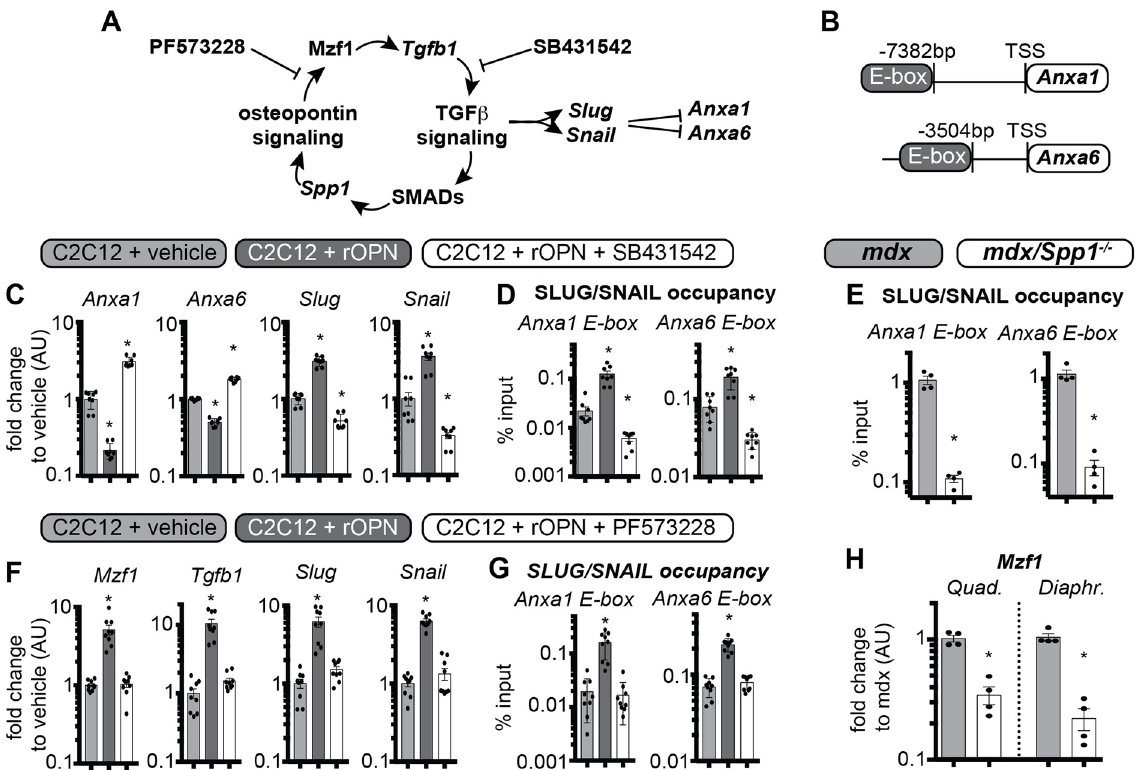
Fig 5. Excessosteopontin and TGF β activation inhibits Anxa1 and Anxa6 gene expression. A) Model depictingthe feed- forward loop in which osteopontin promotes TGF β , which in turn promotes Spp1 /osteopontinexpression. Slug/Snail expression, downstream of TGF β activation, results in Anxa1/Anxa6 gene repression. B) Diagramof putative E-box elementsupstream of transcriptional start site (TSS) of Anxa1 and Anxa6 genes in the murinegenome. C) qPCR analysisof C2C12cells after treatment with recombinant osteopontin (rOPN) or rOPN plus the TGF β inhibitor SB431452. rOPN increased Slug/Snail expression, and this was reversedin the presenceof SB431452. D) Correspondingly,ChIP-qPCR showed that the E-box occupancy of the Anxa1 and Anxa6 promoters by the SLUG/SNAIL protein complex was increasedby rOPN, and this was reversedin the presenceof SB431452. E) Anxa1 and Anxa6 promoter occupancy by SLUG/SNAIL was decreased in the myofiber fraction of mdx/Spp1 -/- muscle compared to control mdx muscle ( gastrocnemius ). F) PF573228, a chemicalinhibitorof OPN-driven signalingleadingto Mzf1-Tgfb1 axis activation,ablatedrOPN-induced upregulation of Slug , Snail , Mzf1 , and Tgfb1 . G) Accordingly, PF573228bluntedrOPN-dependent increasein SLUG/SNAIL occupancyon Anxa1/6 E-boxes in C2C12 myoblasts. H) Mzf1 , transcriptionalregulatorlinkingthe OPN and TGF β signalingcascades, was downregulated in both hindlimb( quadriceps ) and respiratory ( diaphragm ) muscles of mdx/Spp1 -/- comparedto mdx . Histograms, singlevalues & avg ± sem; n = 8 independentreplicates/group for C2C12 myoblast analyses, n = 4 mice/group for mdx / Spp1 -/- mice analyses; (C-D; E-G) * , P < 0.05vs vehicle, 1way ANOVA + Bonferroni; (D) * , P < 0.05vs mdx control, unpairedt-test with Welch’s